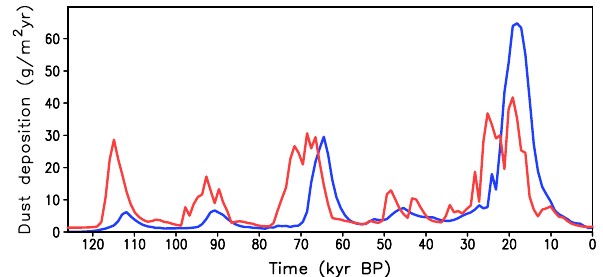
Fig. 10. Simulated temporal evolution of annual dust deposition rates in the grid cell south of the Laurentide Ice sheet (blue) and south of Fennoscandian ice sheet (red). The locations of the grid cells are shown in Fig. 9d by rectangles of corresponding colours.